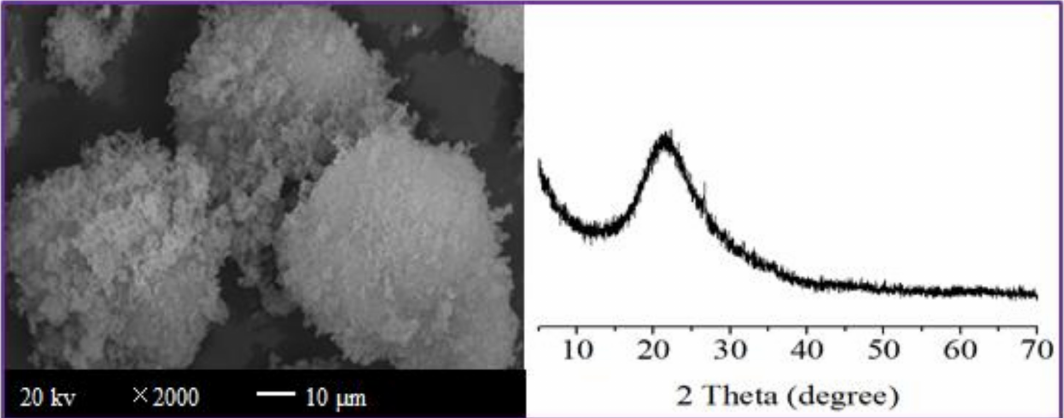
Figure 1. Phase composition and microscopic morphology of the fly ash.